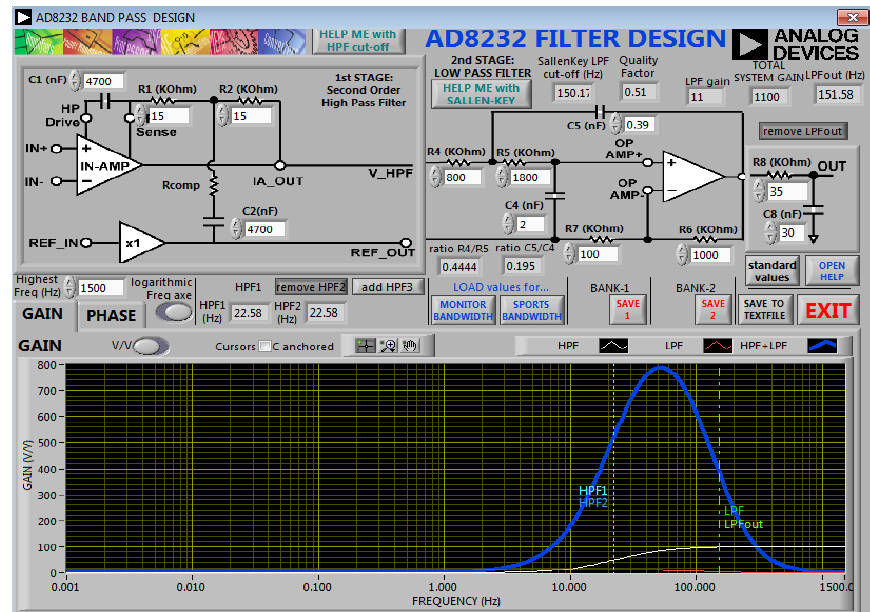
Figure 2. Component selection and response for the band-pass filter using Filter Design software [28]. Copyright © 2019, Analog Devices, Inc. All Rights Reserved.